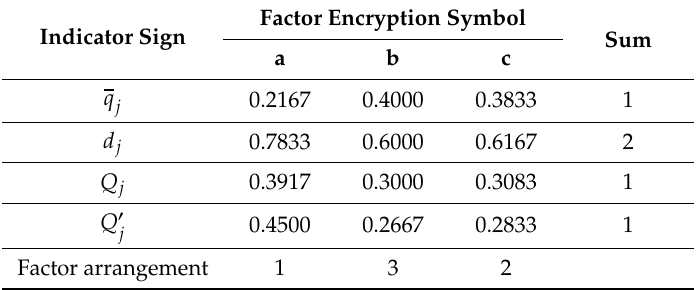
Table 4. Ranks evaluation table.